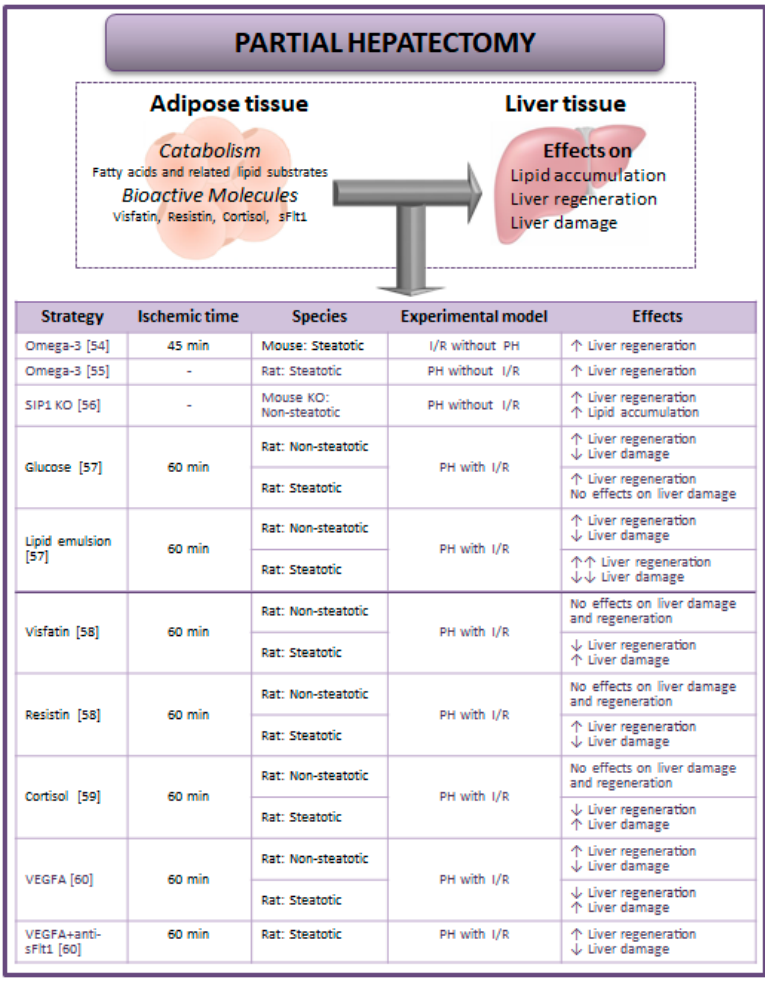
Figure 2. Strategies aimed at regulating hepatic damage and regenerative failure considering the adipose tissue–liver crosstalk during partial hepatectomy (PH) with or without I/R [54–60]. Abbreviations: I/R, ischemia–reperfusion; PH, partial hepatectomy; sFlt1, soluble form of the VEGF receptor 1; SIP1, smad interacting protein 1; VEGFA, vascular endothelial growth factor type A.